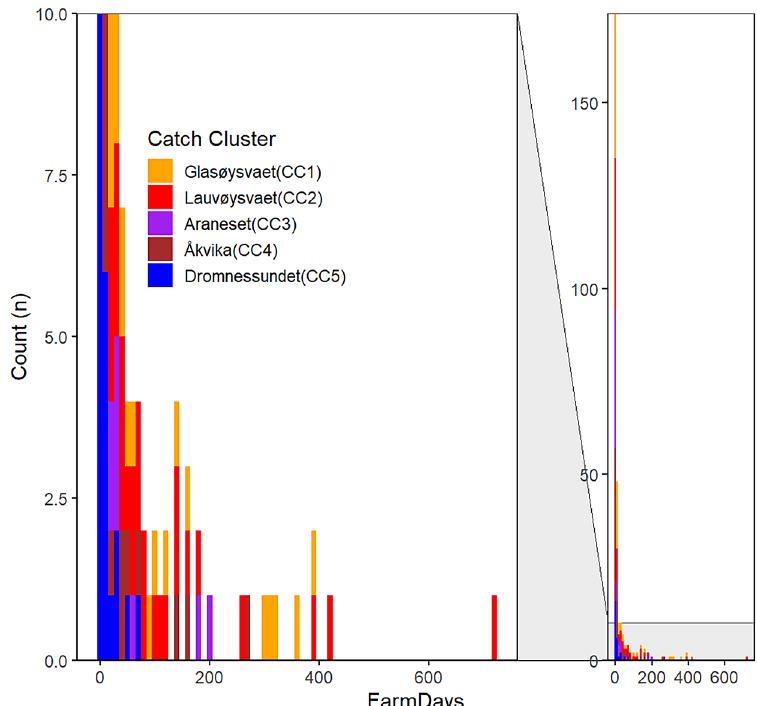
Fig. 5. Number of days cod spent at a salmon farm; bin width: 10 d. Fill colours represent catch clusters (CC). Left panel: results of bins with ≤10 counts